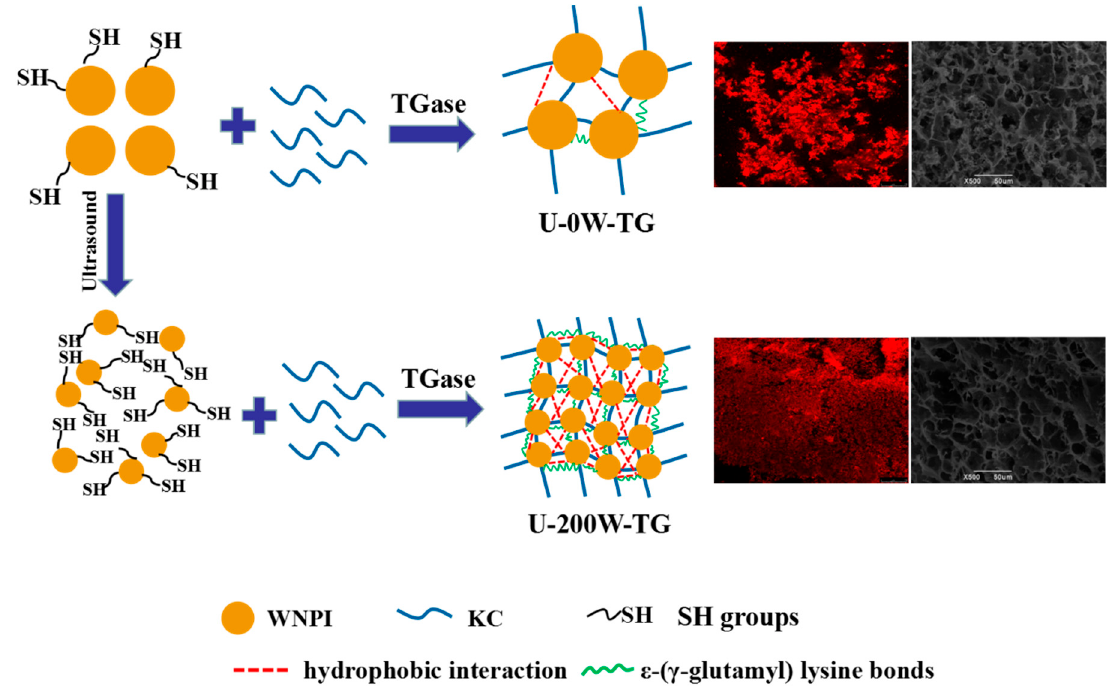
Figure 7. Schematic mechanism of WNPI-KC gel formation after treatment with ultrasound.